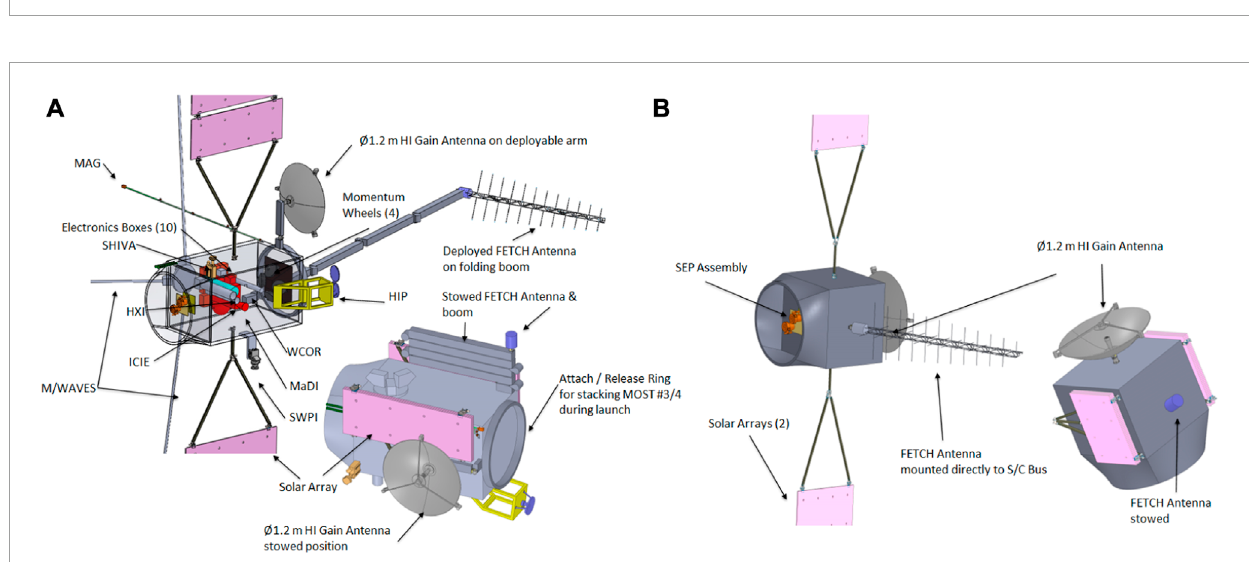
FIGURE 4 (A) MOST1 and 2 with the full instrument suite. (B) MOST3 and 4 with FETCH elements. See Gopalswamy et al., 2022 for details about the other instruments. The FETCH antenna is a log-periodic cross-dipole antenna extending approximately 3 m on its axis. The elements are illustrative only. The antenna boom on MOST1 and 2 is necessary to keep it out of the field of view of